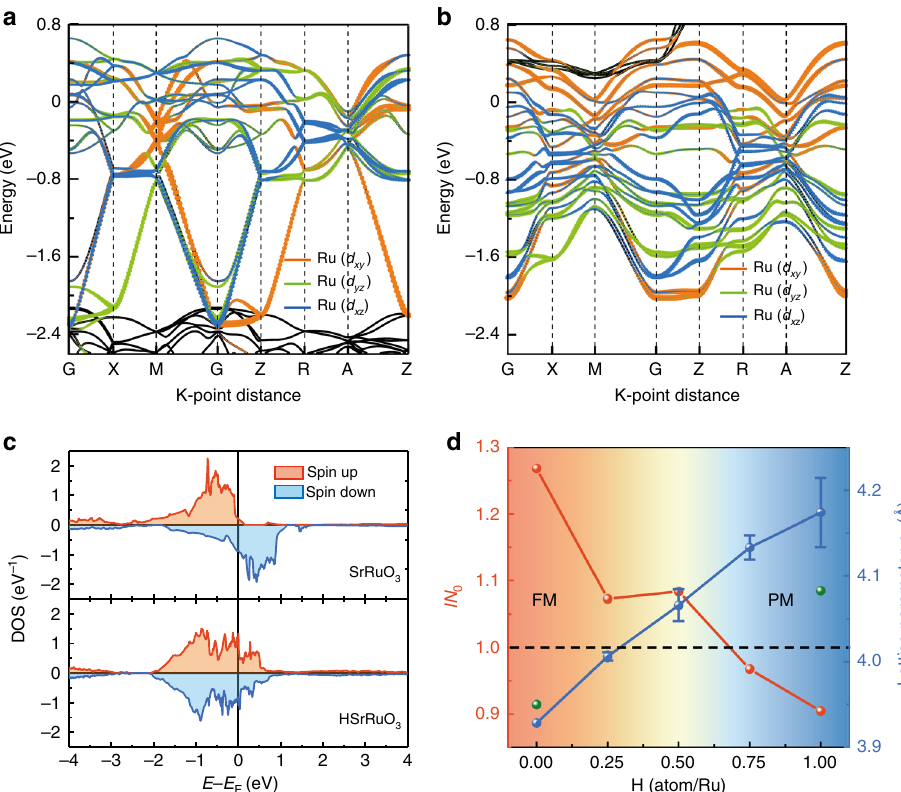
Fig. 3 Mechanism for the protonation induced magnetic phase transition. a , b , Calculated electronic band structures for ( a ) pristine SrRuO 3 and ( b ) HSrRuO 3 with nonmagnetic General Gradient Approximation (GGA) calculations. c Spin-resolved density of states for pristine SrRuO 3 and protonated HSrRuO 3 calculated by GGA. d Calculated Stoner criterion parameter IN 0 and c -axis lattice parameter as a function of hydrogen concentration. The green points are the experimental lattice parameters (doubled of the pseudo-cubic lattice constant) obtained from the in-situ XRD measurements. Following the Stoner criterion, when IN 0 becomes smaller than 1 with the increase of hydrogen concentration, the ferromagnetic (FM) SrRuO 3 transits into a paramagnetic (PM) metal. The error bars are calculated from different possible H x SrRuO 3 crystalline